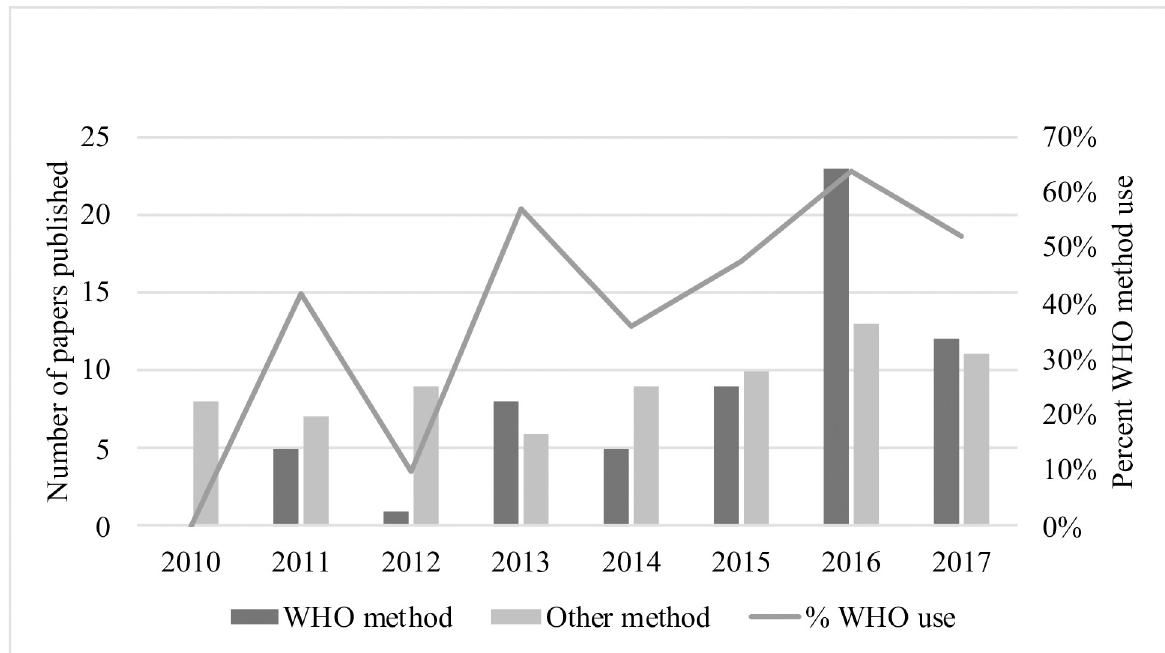
Fig 3. Trends in use of WHO near-miss approach or other methods,